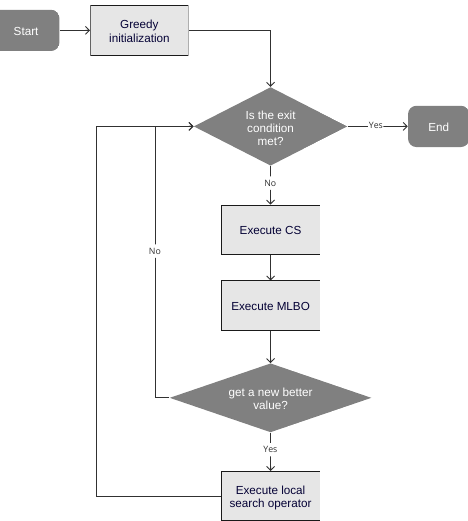
Figure 1. Machine learning cuckoo search binary